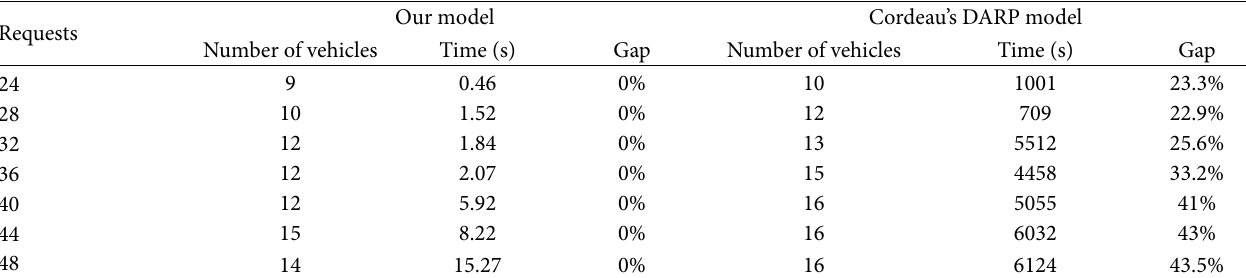
Table 3: Model performance comparison (random